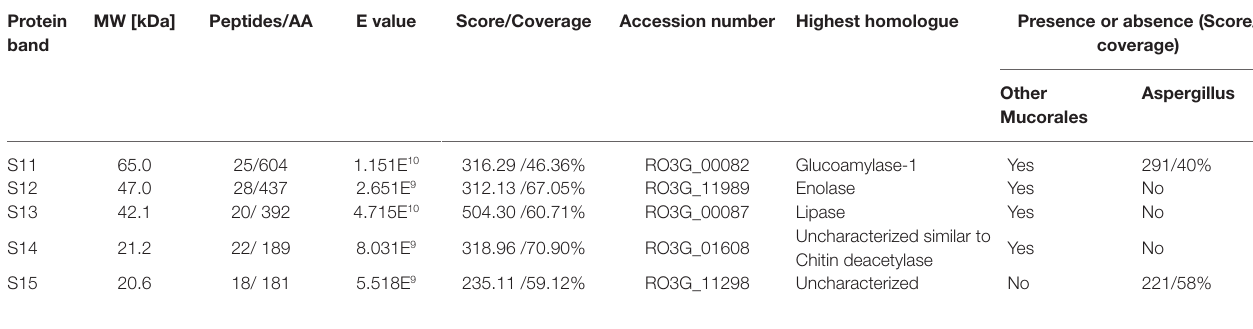
TABLE 2 | Protein sequences identified by LC–MS/MS in the supernatant of R. arrhizus var. delemar fungus growing in contact with lung epithelial cells compared to controls, the fungus and mammalian cells alone. Protein